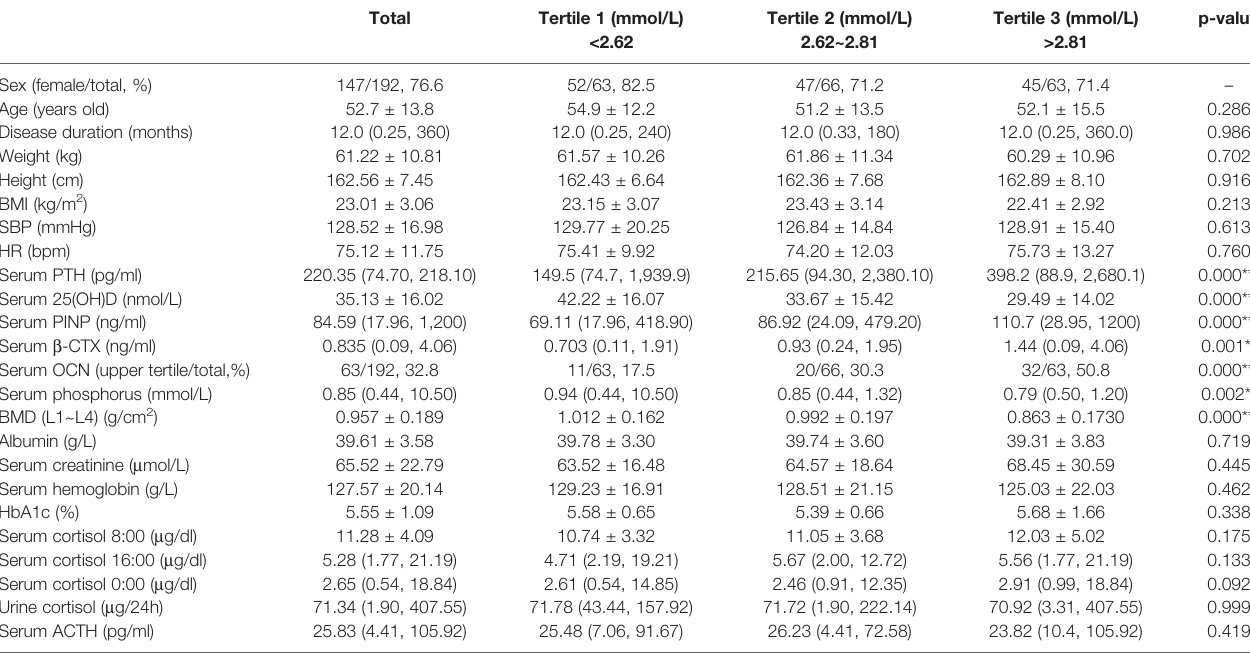
TABLE 3 | Baseline characteristics of PHPT patients in different calcium tertile